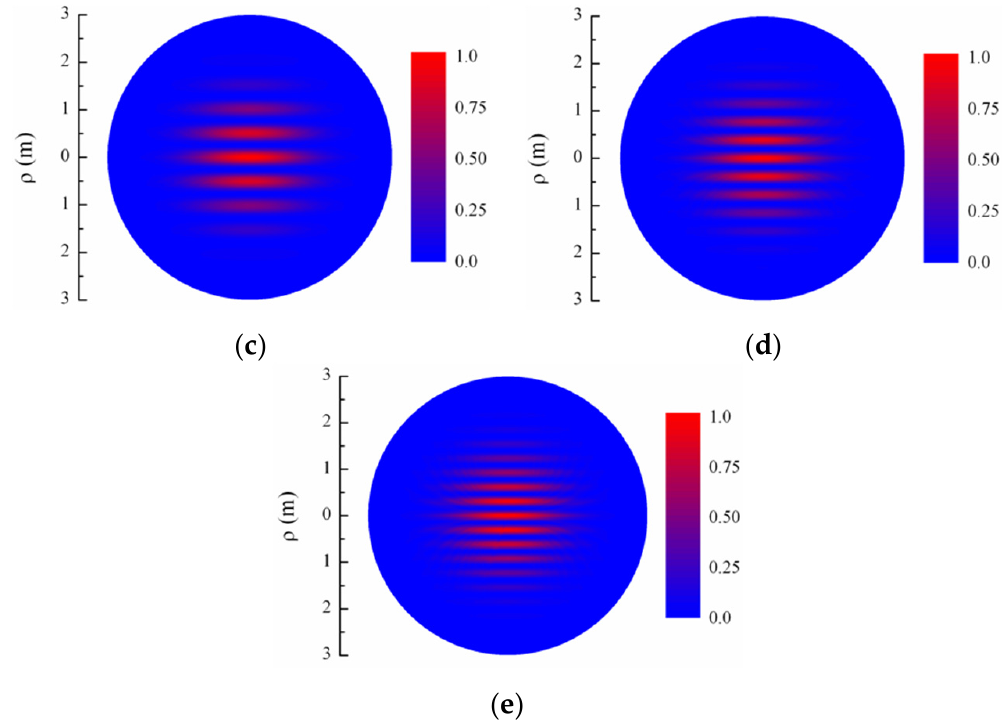
Figure 5. The average intensity of interferometric laser scanning (ILS) interference pattern for different values of ρ tr : ( a ) 1 cm; ( b ) 2 cm; ( c ) 3 cm; ( d ) 4 cm; and ( e ) 5 cm.